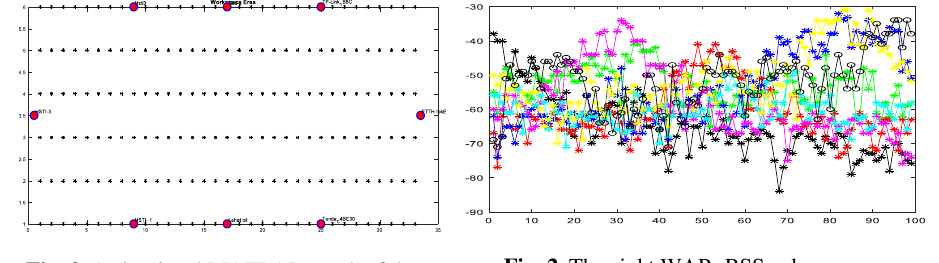
Fig. 3. A simulated-MATLAB graph of the real survey for the Koya-PICS